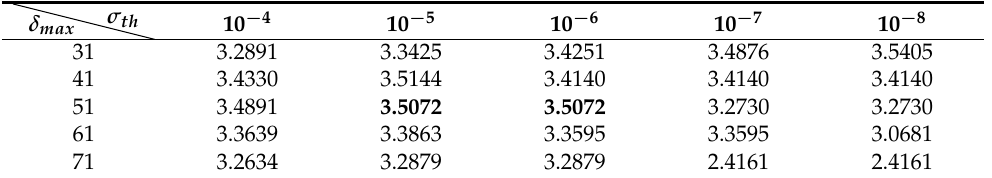
Table 5. The estimated multi-spectral fractal dimension (MFD) of the Pavia University multi-spectral image (left upper corner).